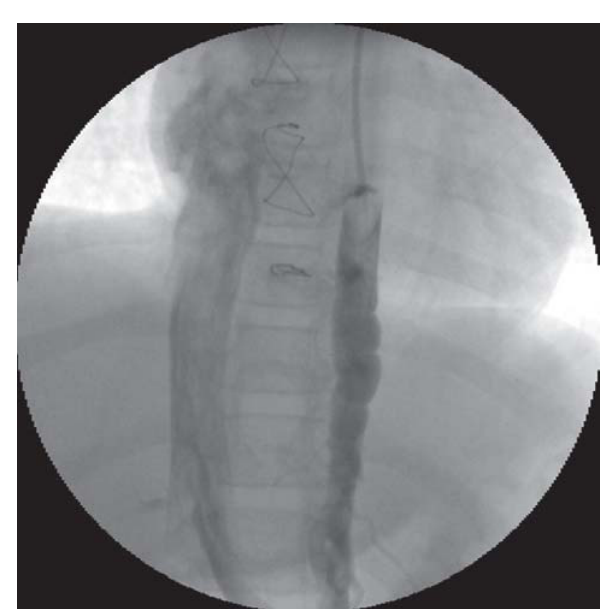
Fig. 6 – Cateter na veia hemiázigo contrastando sua drenagem para o sistema da veia cava inferior e retorno ao átrio